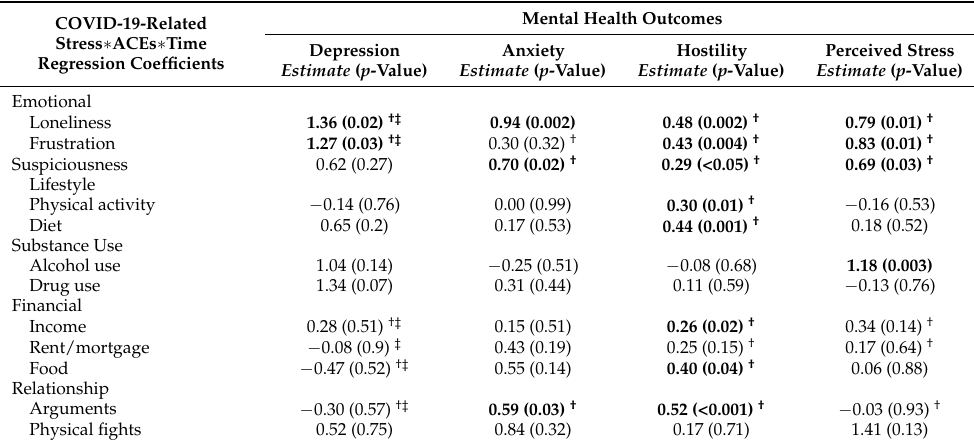
Table 3. Longitudinal mixed effects models predicting changes in mental health outcomes as a result of the interaction between COVID-19 stressors and exposure to ACEs over time 1 . COVID-19-Related Stress ∗ ACEs ∗ Time Regression